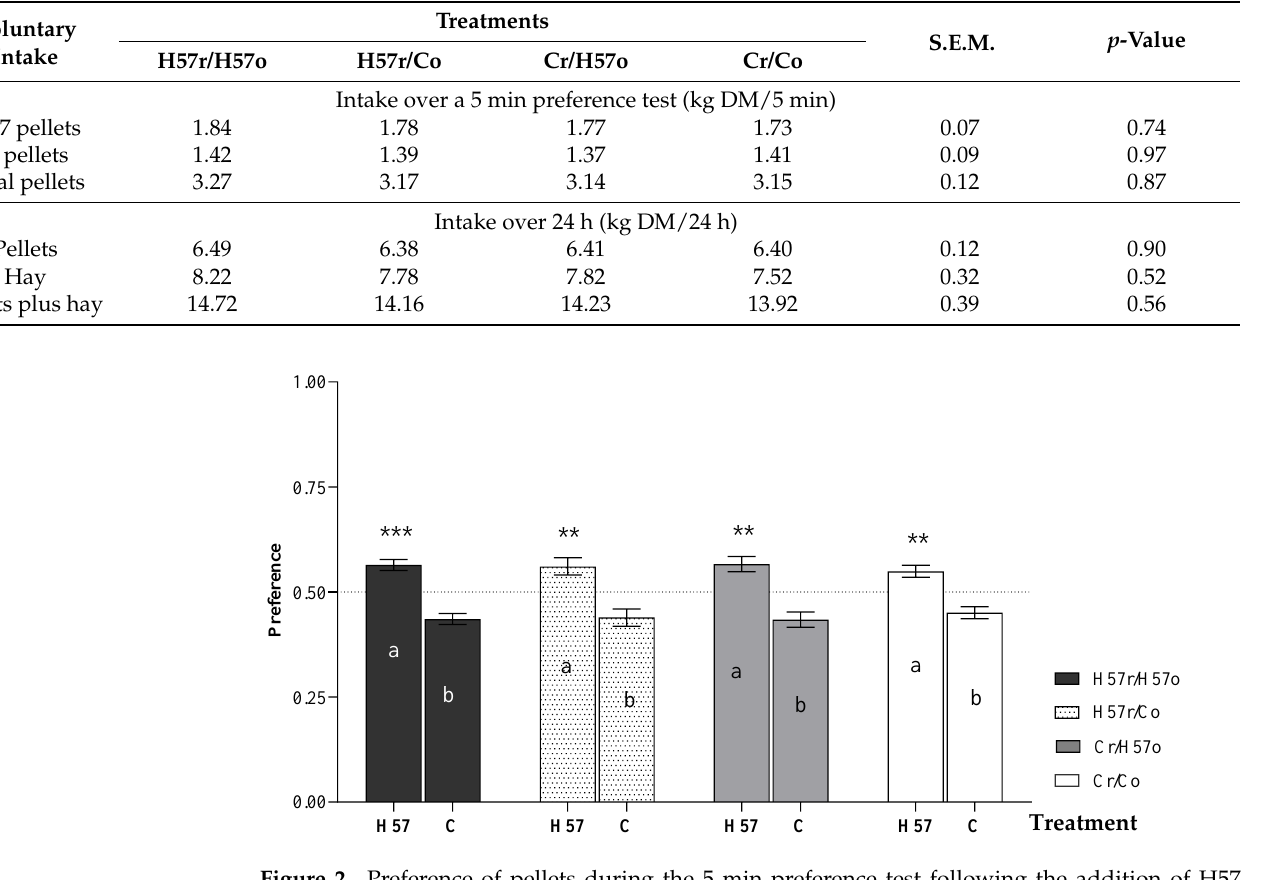
Table 2. Daily and short-term (5 min preference) feed intakes (kg dry matter, DM) of steers given either H57 or C pellets that were ingested either orally (o) or introduced into the rumen (r) in the morning feeding.